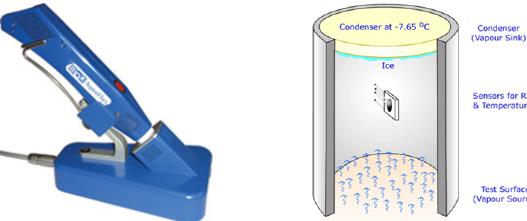
Figure 3. AquaFlux TM AF200 evaporimeter. Overall view of the device ( left ) and scheme of the measuring chamber ( right